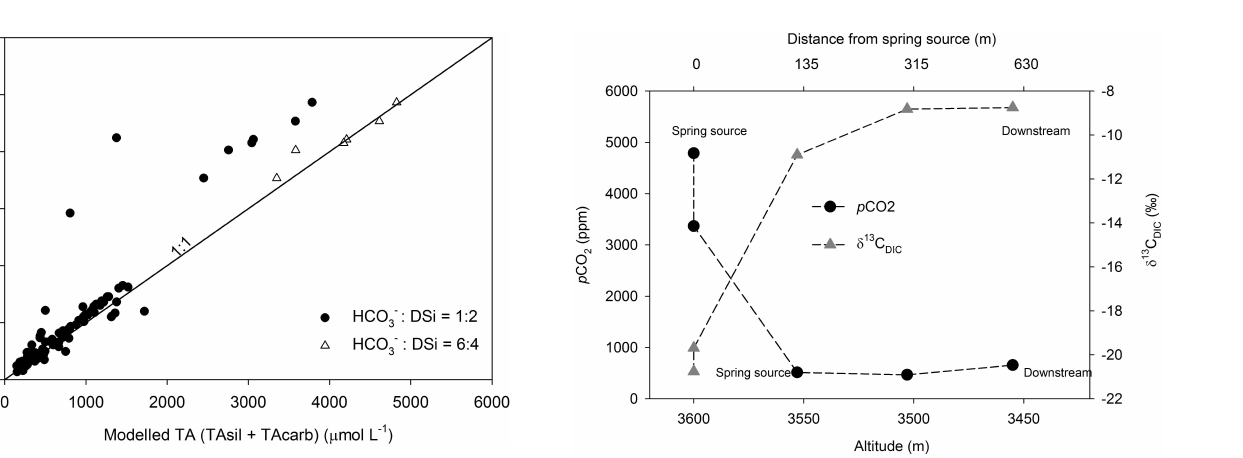
Fig. 16. A plot showing behaviour of CO 2 concentration and δ 13 C DIC at the Satima springs groundwater source in the headwa- ters of the Aberdare